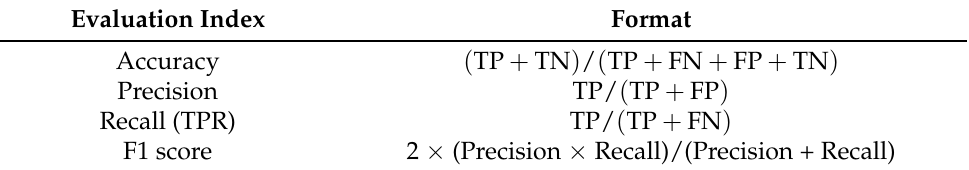
Table 5. Four classification evaluation